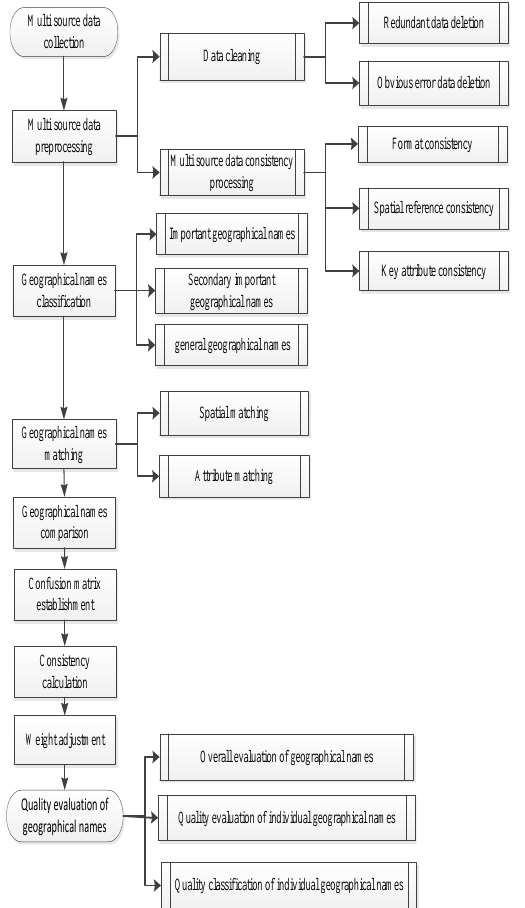
Figure 1 . evaluation process of geographical names